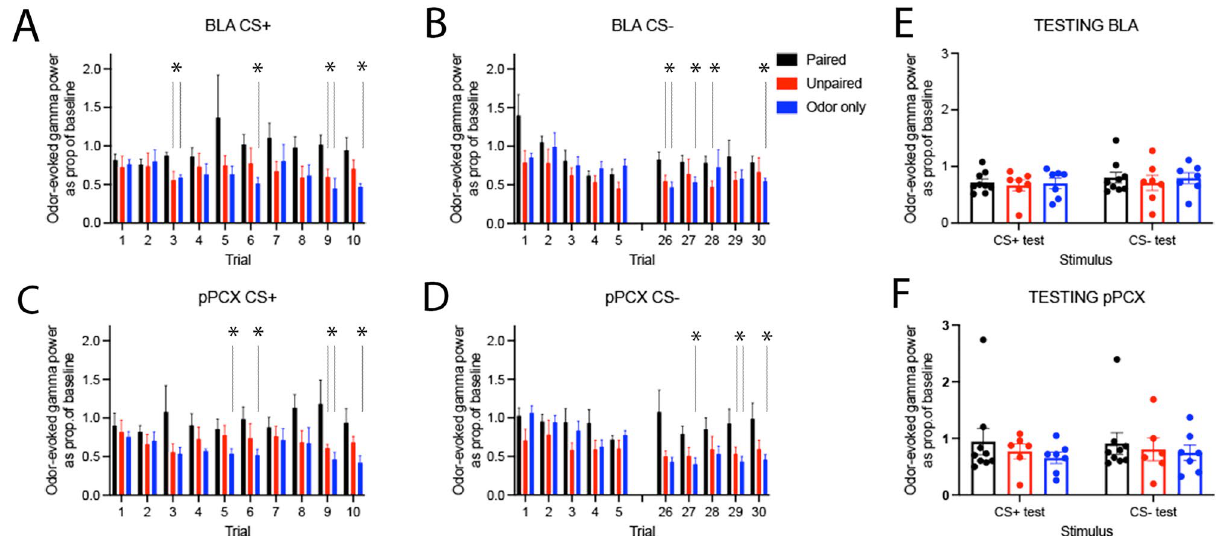
Figure 3. Normalized odor-evoked high gamma response for each of the first 5 trials and last 5 trials of the CS+ and CS− in both regions. The CS + was delivered 10 times and the CS− was deliver 30 times. High gamma was significantly greater in Paired animals than controls in both the BLA ( A , B ) and the pPCX ( C , D ), with differences emerging within the first 5 trials for the CS+ but not until later trials for the CS− (asterisks signify significantly larger responses in the Paired animals compared to specific controls as identified with vertical lines, p < 0.05). No differences were observed during testing in either the BLA ( E ) or pPCX ( F ).